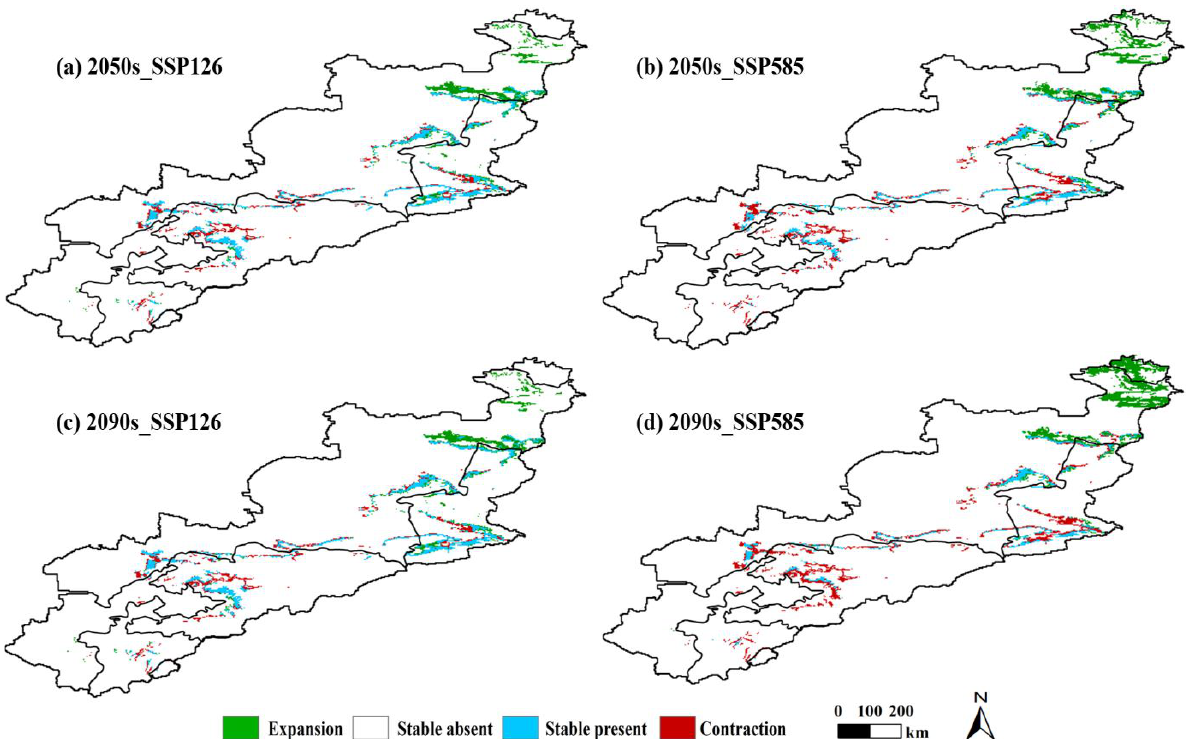
Figure 3. Changes in suitable habitat for wild apple in the 2050s ( a , b ) and 2090s ( c , d ). Red colors indicate the loss of suitable habitats, green indicates newly increased suitable habitats, and blue indicates stable habitats.